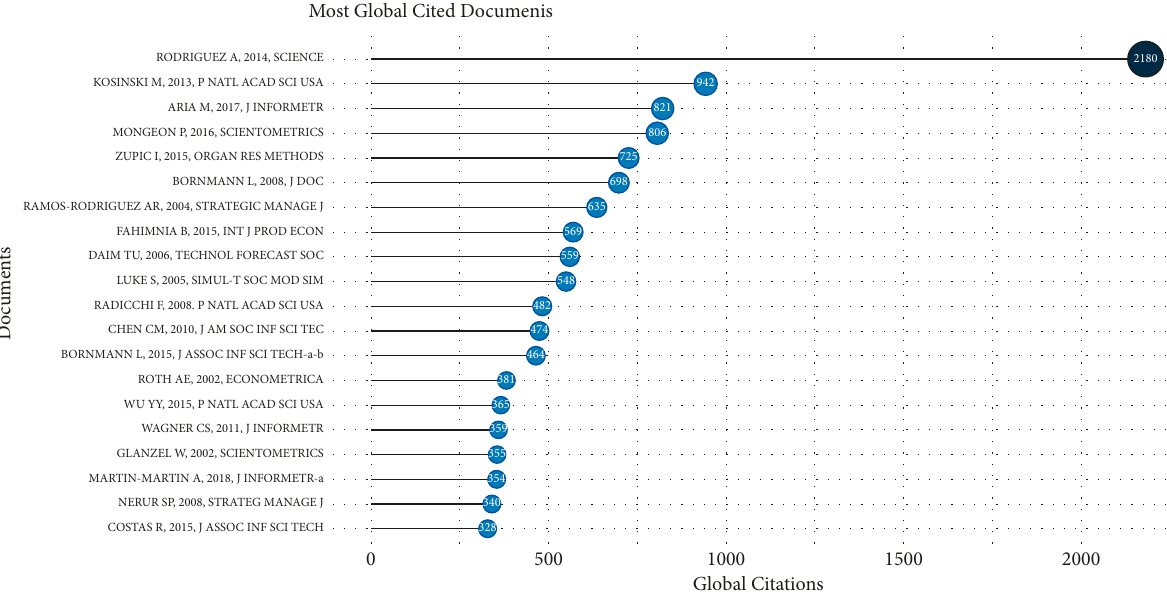
Figure 4: Top 20 cited literature.